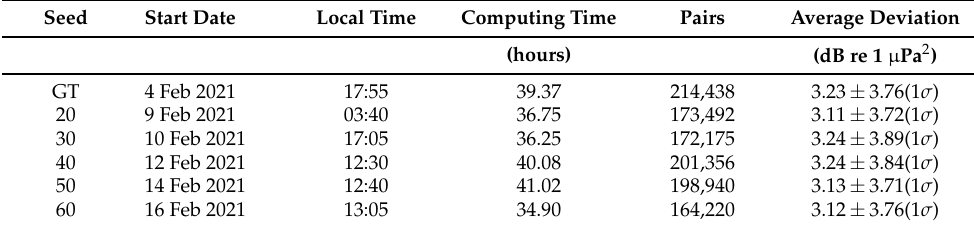
Figure 3. Density plot of the point-to-point comparison of the clo-BB Gassmann vs. clo-BB RAM predic- tions for ( a ) the upper half (or training subsample) of the GT simulation and timestep numbers not divisible by 10 between 1440 and 5040 (see text), and ( b ) the lower half (or testing sub-sample) of the GT simulation and timestep numbers not divisible by 10 between 5041 and 10,080 (see text). A binsize of 1 dB was used to process the square maps with colored density levels between 0 and 250 counts. Table 3. GT results and application/validation of additional